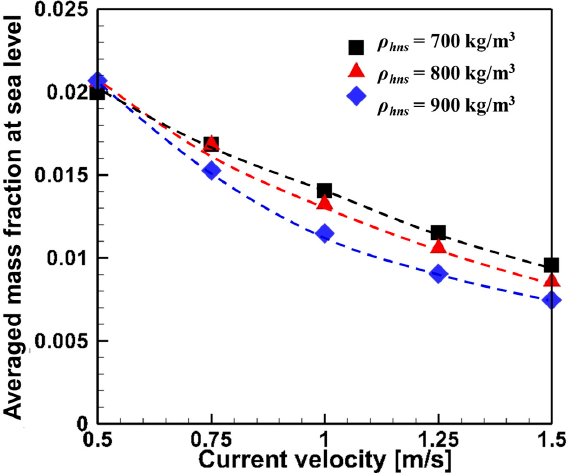
Figure 7. The HNS concentration at sea level for the input variables ( v c and ρ hns ).